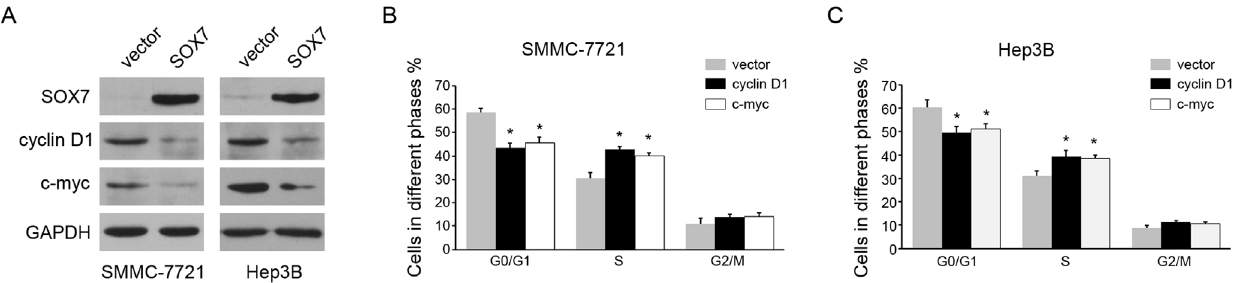
Figure 4. SOX7 induced G1 to S phase arrest by down-regulation of cyclin D1 and c-myc. (A) Western blotting analysis of SOX7, cyclin D1, c-myc and GAPDH levels in SMMC-7721 and Hep3B cells transfected with vector or SOX7. (B, C) Overexpression of cyclin D1 and c-myc could override G1 to S pahse arrest induced by SOX7. Cyclin D1 or c-myc was overexpressed in SOX7-overexpression cells, and the cell percentages in G0/G1, S and G2/M phase were measured by flow cytometric analysis. * indicates p , 0.05. The experiments were performed independently three times at